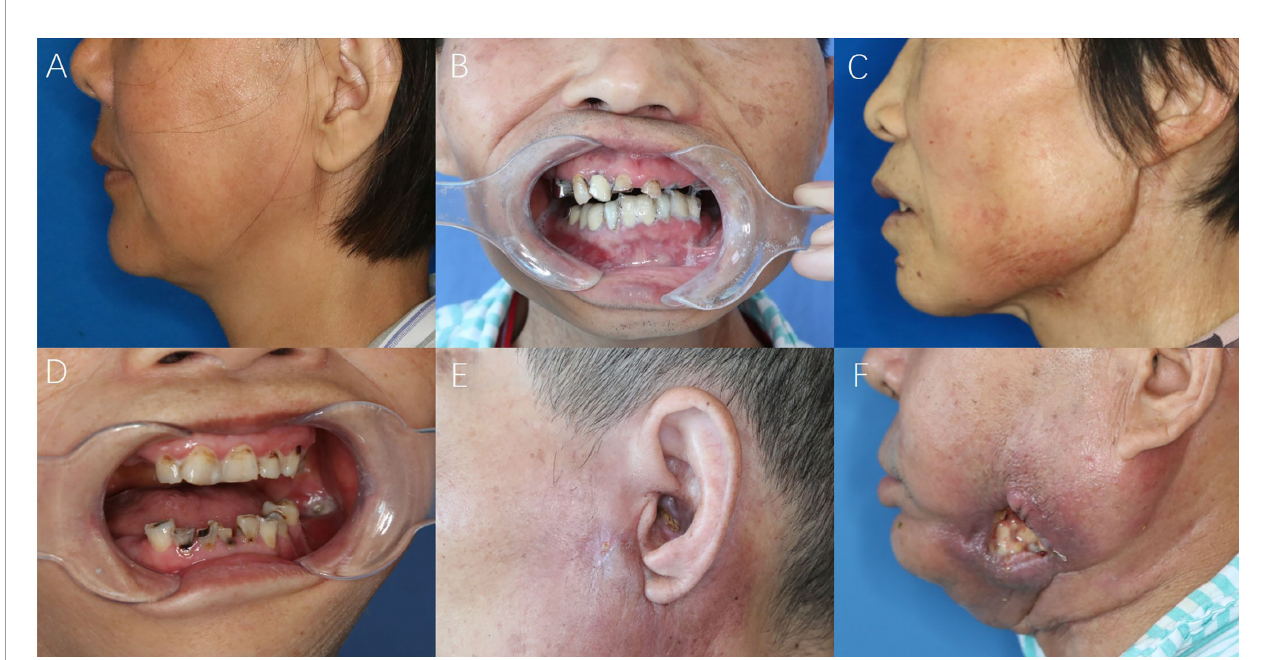
FIGURE 1 | The symptom-based scoring system for STI evaluations. (A) Stiffness of masseter or cervical muscles; (B) Dif fi culty in mouth-opening (trismus); (C) Swelling and skin discolor; (D) Intraoral mucosal fi stula; (E) Extraoral cutaneous fi stula; (F) Large oro-cutaneous fi stula with persistent